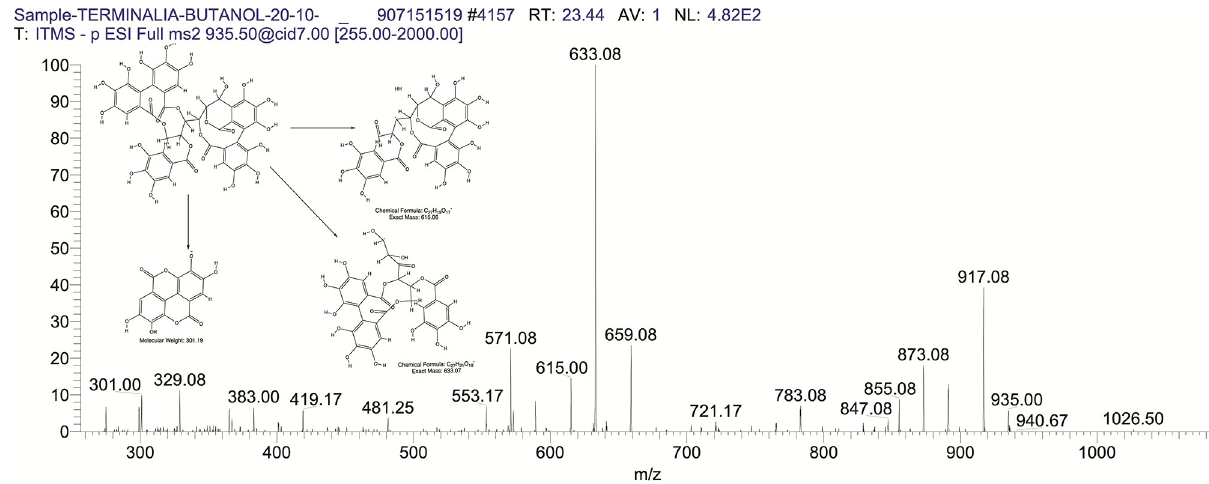
Fig 10. The mass spectrum of casuarinin and its fragmentation pattern.